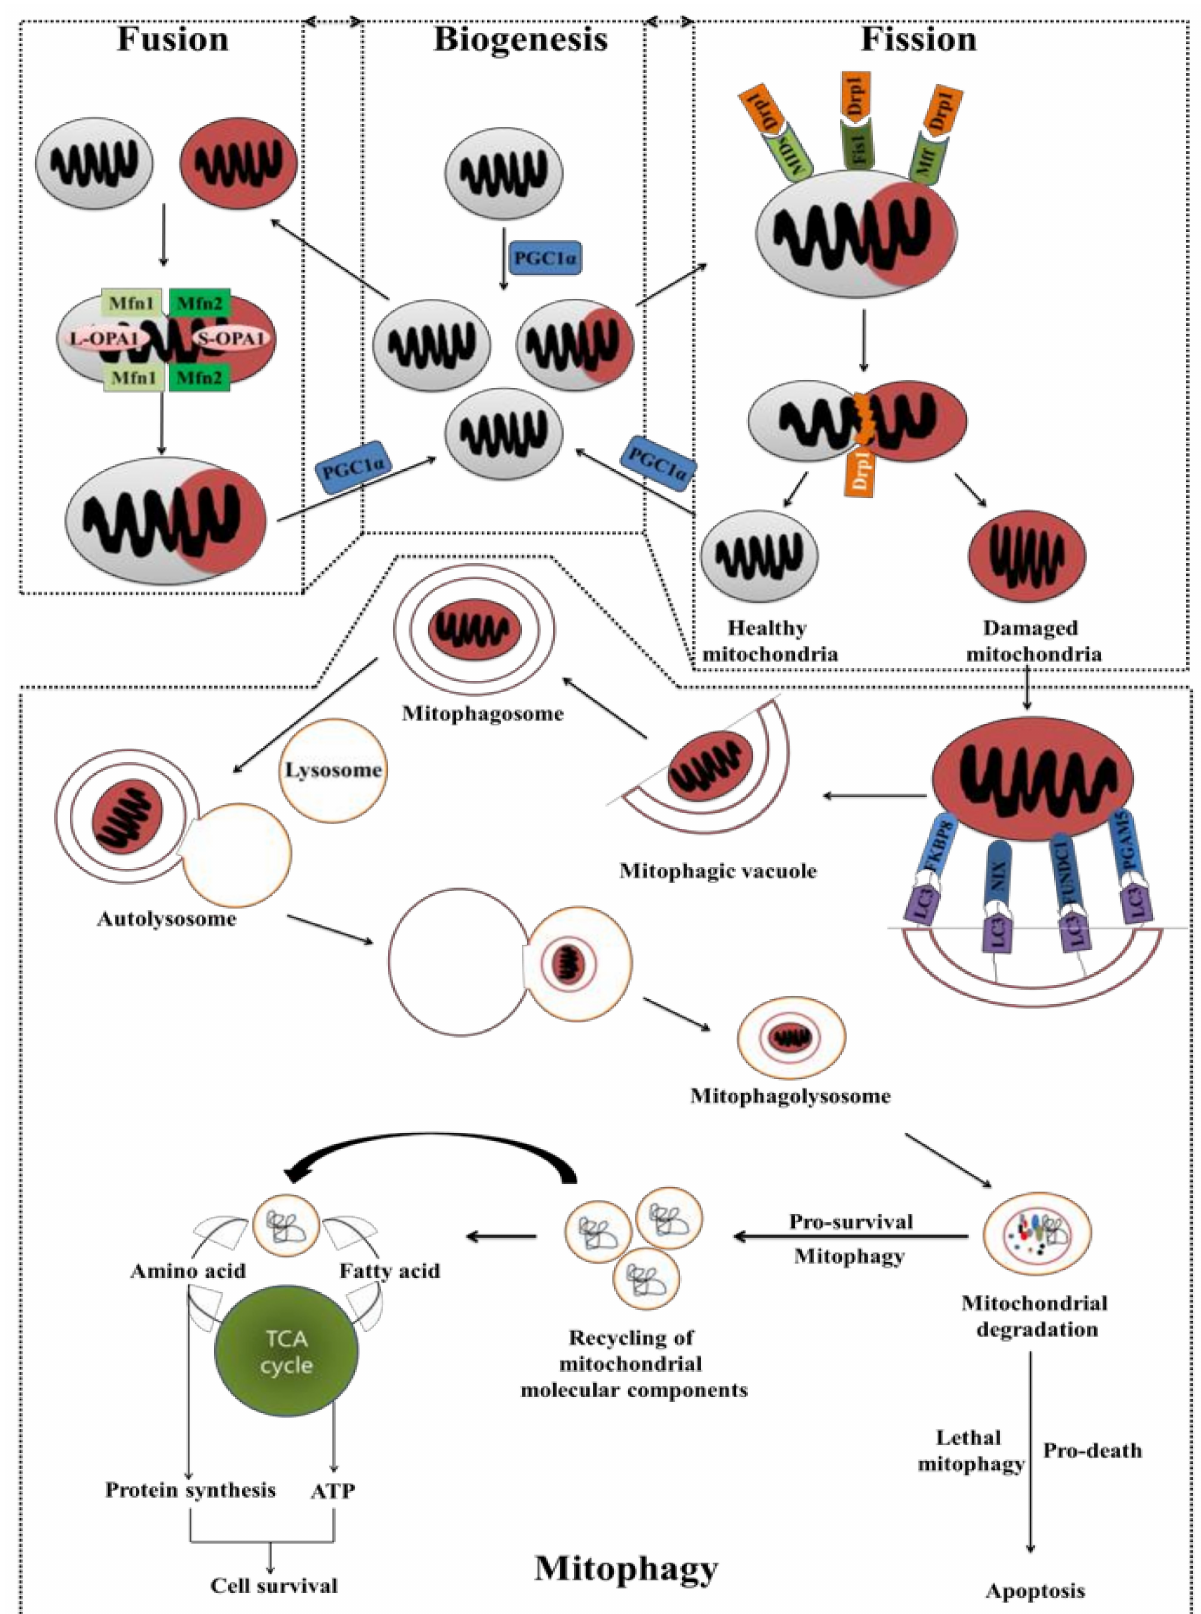
Figure 6. The role of mitochondrial biogenesis and mitophagy in chemotherapy resistance. Mi- tochondrial biogenesis, fusion, fission, and mitophagy are cellular mechanisms that